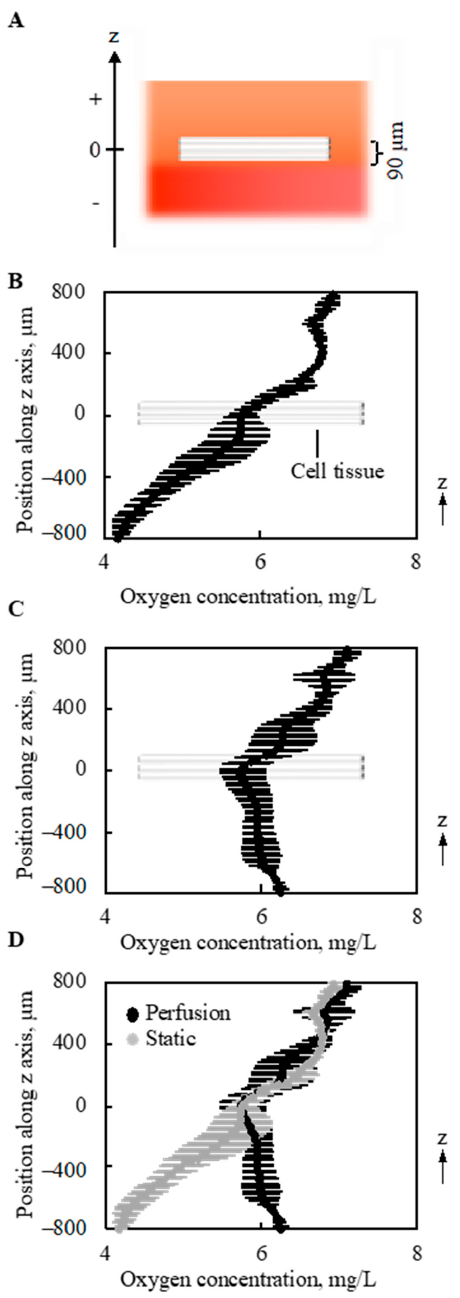
Figure 6. Oxygen concentration around and in the tissue ( n = 3). The schematic image showing measured region ( A ). Without perfusion, a gradual decrease in the oxygen concentration was shown along with the depth direction ( B ). However, owing to the perfusion, the minimal point of oxygen concentration was at the location of the cell tissue ( C ). On the other hand, the density of oxygen itself around the cell tissue is very similar. The results shown in ( B , C ) were overlapped for comparison ( D ). Note that the perfusion speed is 5 mL/min.